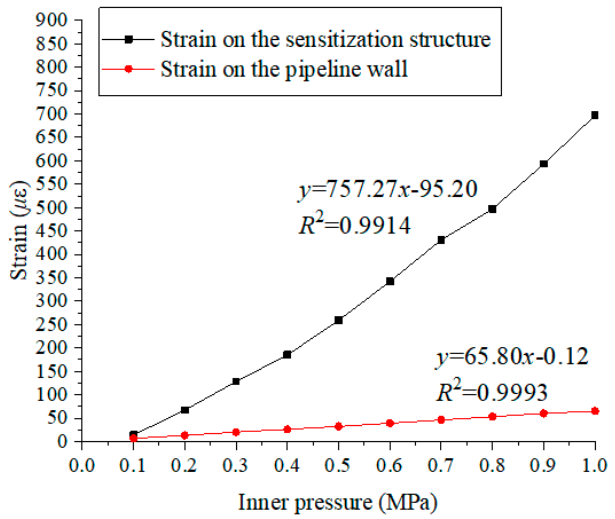
pipeline’s outside surface.